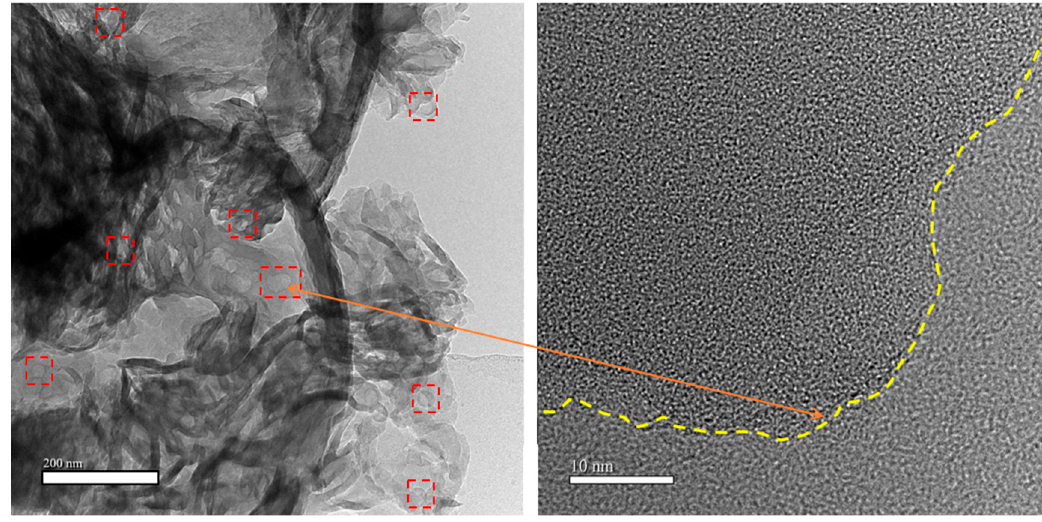
Figure 3. TEM and HRTEM images of g-C 3 N 4 /CQD composites.